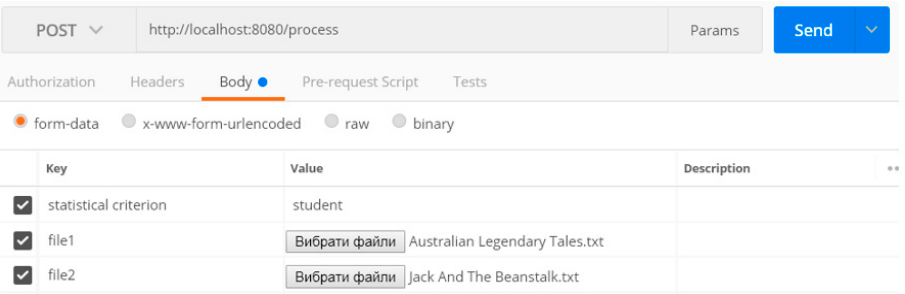
Figure 2. The algorithm of identifying the group with a high differentiating capability.